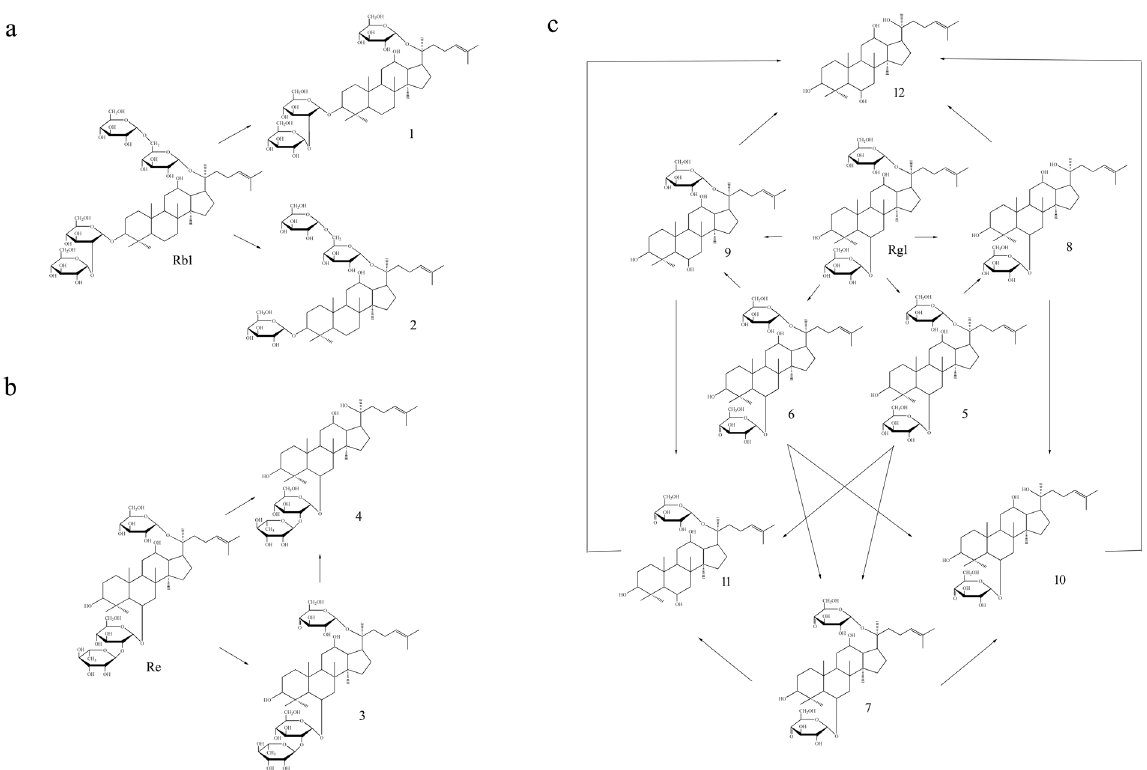
Figure 2. Biotransformation pathways of ginsenoside Rb1 ( a ), Re ( b ), and Rg1 ( c ) during biotransformation process by using Cellulosimicrobium sp.